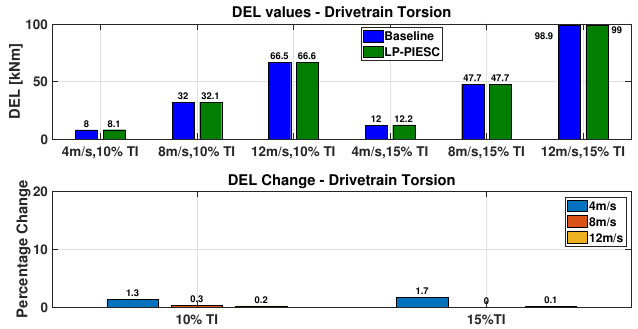
Figure 34. Drivetrain torsion comparison: Baseline vs. LP-PIESC. Aggregate DEL values with baseline controller and LP-PIESC ( top ), percentage change in DEL ( bottom ) for time series from 150 s to 3000